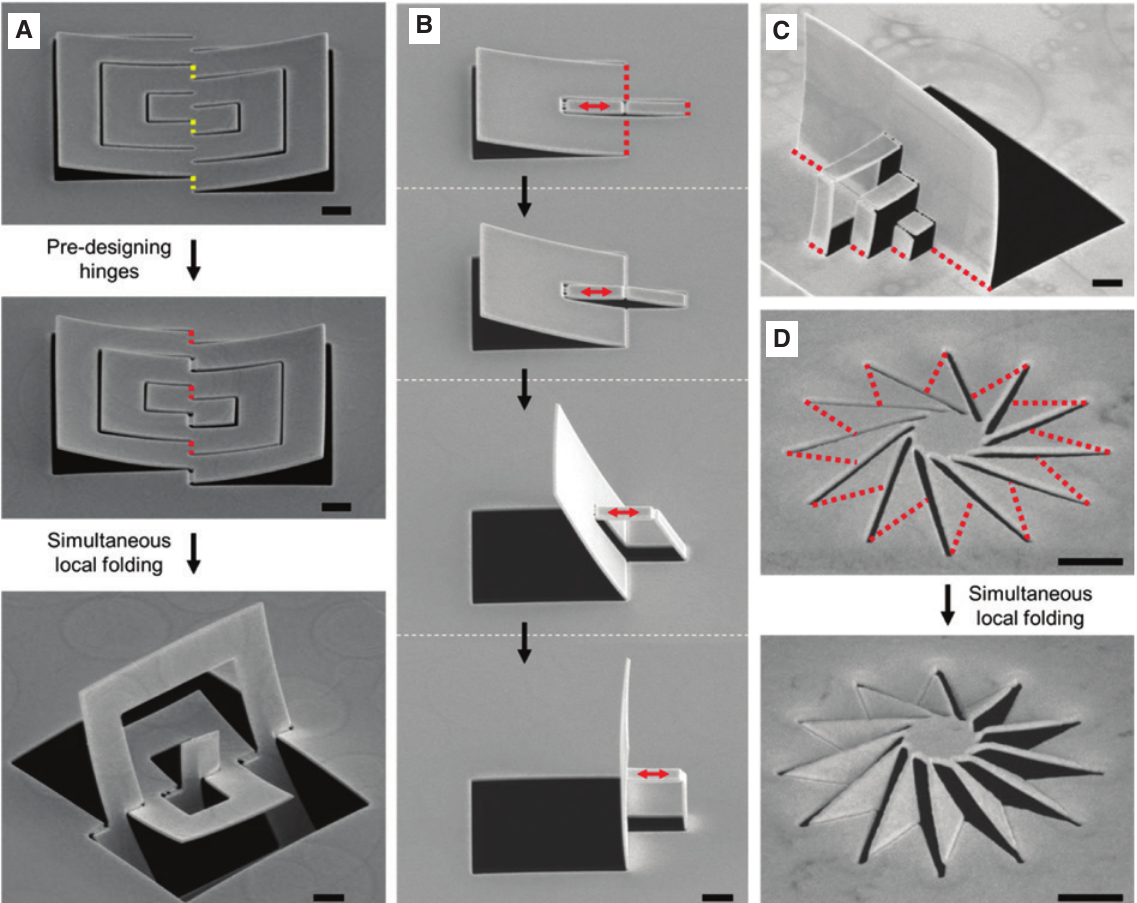
Figure 5: Local FIB-irradiation-enabled close-loop nano-kirigami. (A) Fabrication of a nested-frame structure by predesigning hinge lines along the yellow dashed lines and then parallel scanning along the red dashed lines with local FIB irradiation. (B) Fabrication of a pop-up plate by parallel FIB scanning along the red dashed lines [40]. The rectangular plate, denoted by the double-headed arrow, is popped up by the forces delivered from the neighboring subunits during their upward foldings. (C) Multiple pop-up plates induced by parallel FIB irradiation along the red dashed lines. (D) Fabrication of a star-like structure under parallel FIB irradiation along the red dashed lines. Scale bars: 1 μ